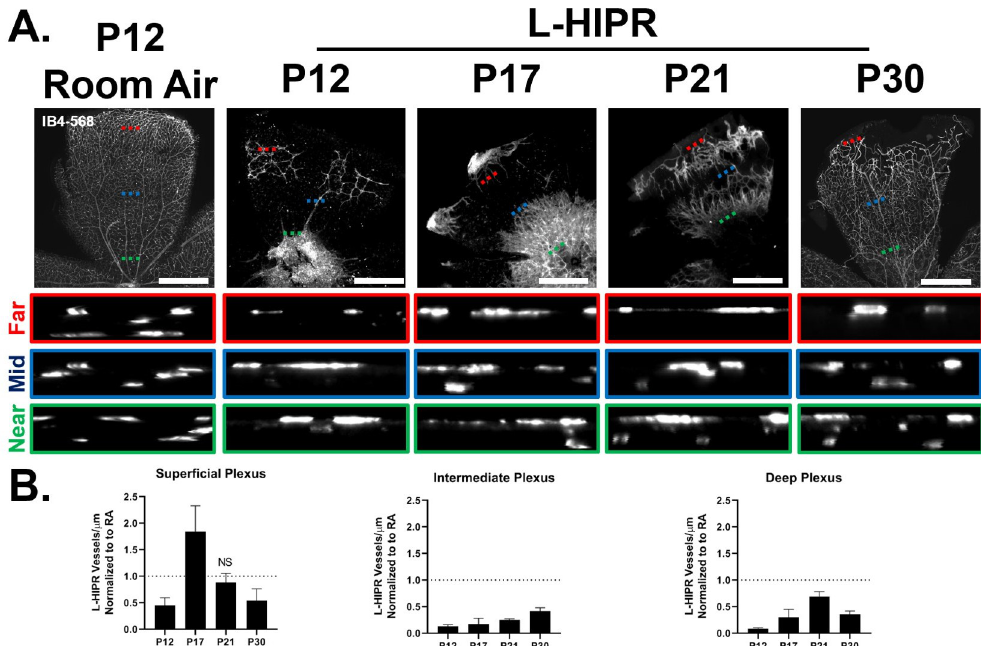
Fig 2. L-HIPR causes delayed retinal vascular development. (A) Retina flat-mount samples ( n = 3) from both room air and L-HIPR groups at P12, P17, P21 and P30 were stained with aIB4 to detect the vascular development. There is sporadic vascularization at P12 in L-HIPR and by P30 the vasculature fails to completely reach the retinal margin. L-HIPR vessels also appear tortuous and dilated, particularly at P17 and P21. XZ spinning disc confocal line scans of IB4 labeled retinal flat- mounts were acquired to visualize the delayed vascular plexuses in L-HIPR. Scans were taken near the optic nerve, mid- retina, or periphery and relevant XZ optical scan insets are denoted by green, blue, and red dashed lines, respectively. (B) Quantification of blood vessel density within the 3 vascular plexuses in L-HIPR normalized to age matched room air control. Non-significant outcomes were marked as NS, all others are statistically significant, p < 0.05, two-sided t -test. Scale bars equal 300 μ